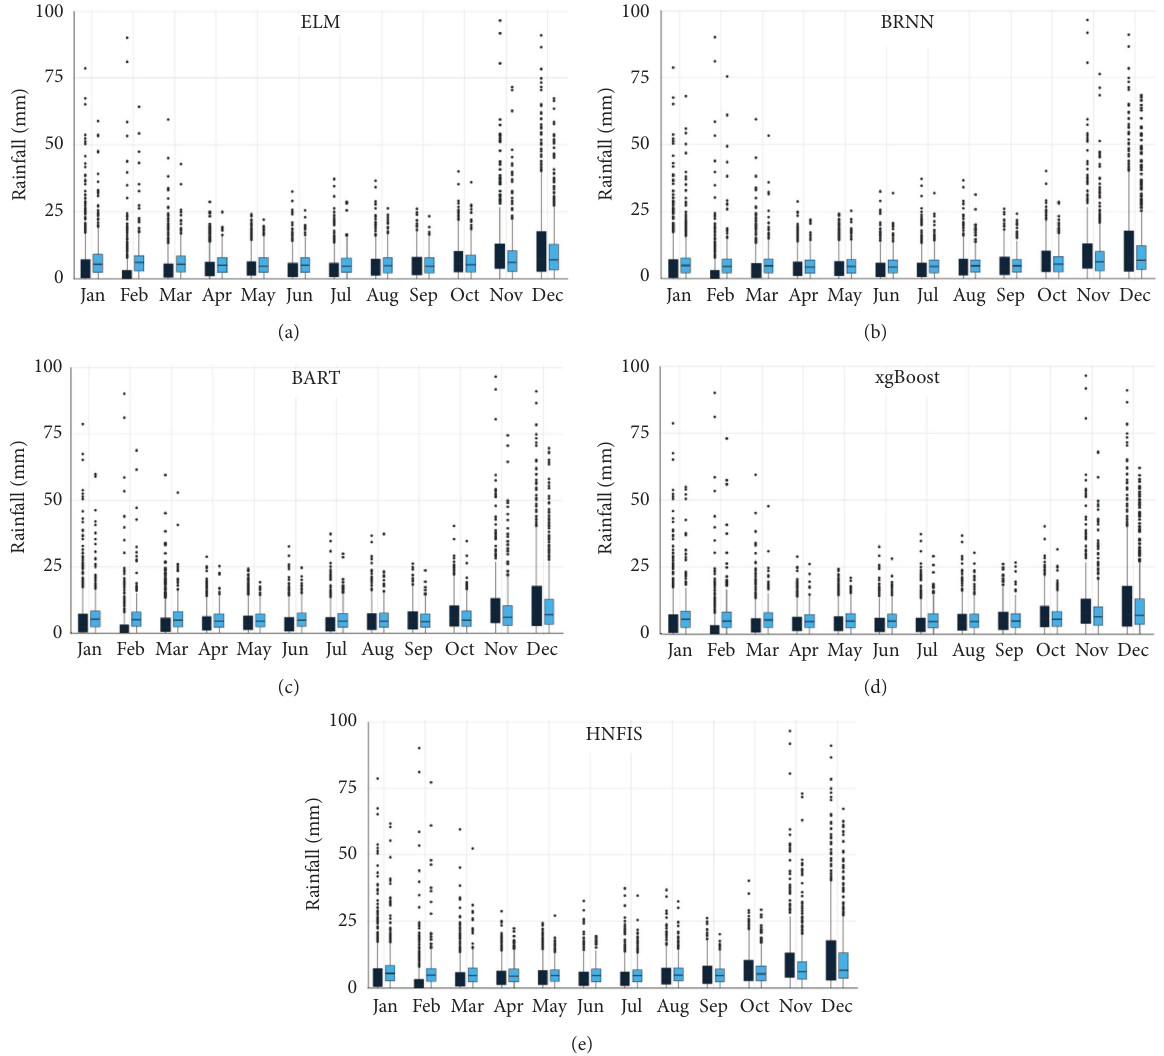
Figure 11: Side-by-side presentation of whisker-box plot of observed and simulated rainfall by the model showing the capability of the models in simulating rainfall for each month and replicate the seasonal variability of rainfall in the study area.